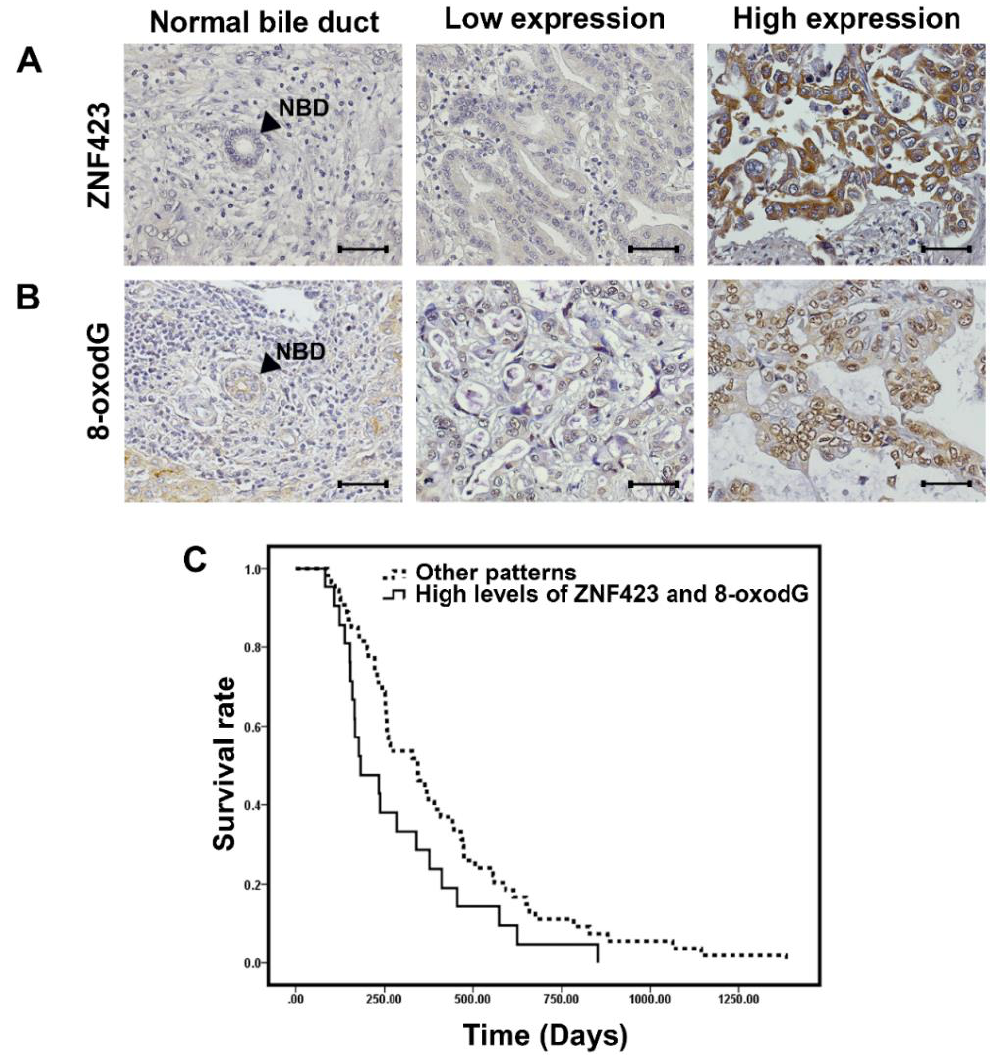
Figure 1. Representative immunohistochemical staining patterns of Zinc finger protein 423 (ZNF423) ( A ) and 8-oxodG ( B ) in cholangiocarcinoma (CCA) and a normal bile duct (NBD) in the adjacent noncancerous area. NBD was indicated by the arrows. All figures are 400x original magnification. Scale bar is equal to 50 µm. ( C ) Kaplan-Meier survival curves illustrating the correlation between the high levels of ZNF423 and elevated formation of 8-oxodG and overall survival rates in CCA patients. CCA patients with high ZNF423 expression adjunct with high 8-oxodG formation ( n = 22) were significantly associated with short survival compared to other patterns ( n = 53), corresponding to those patients with either high ZNF423 alone or 8-oxodG alone or low levels of both ZNF423 and 8-oxodG. Log-rank test analyses revealed significant di ff erence between the two groups ( p =